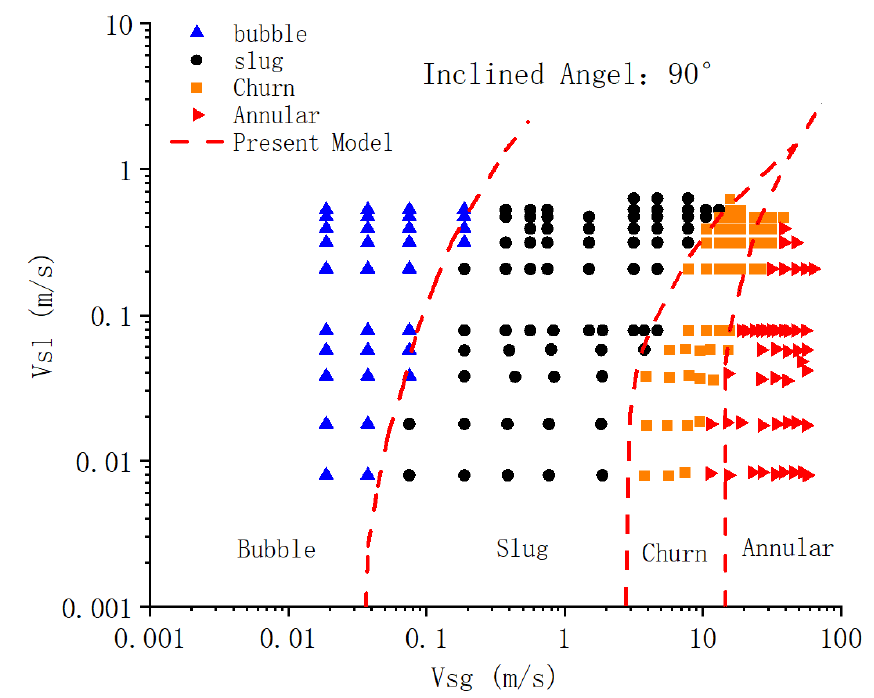
Figure 11. Flow pattern distribution of gas-liquid two-phase flow in the annulus pipe at an inclination angle of 90°.